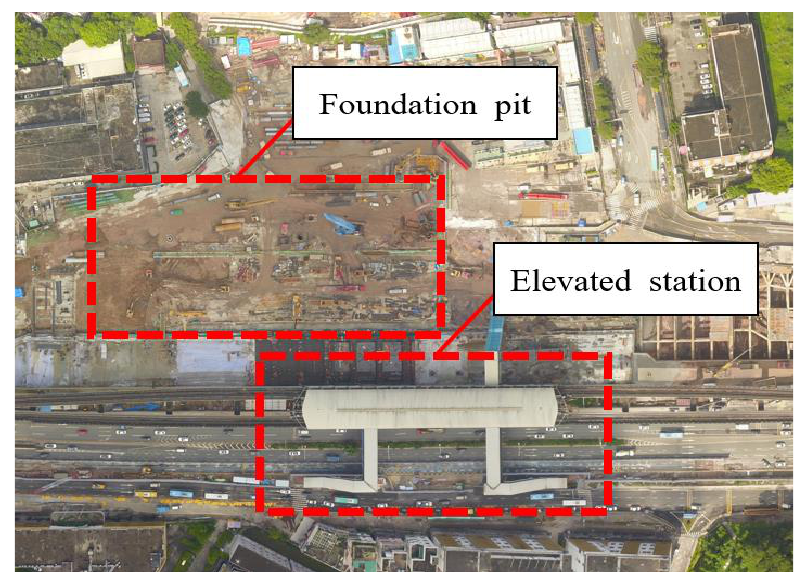
Figure 2. Overhead view of the project site.